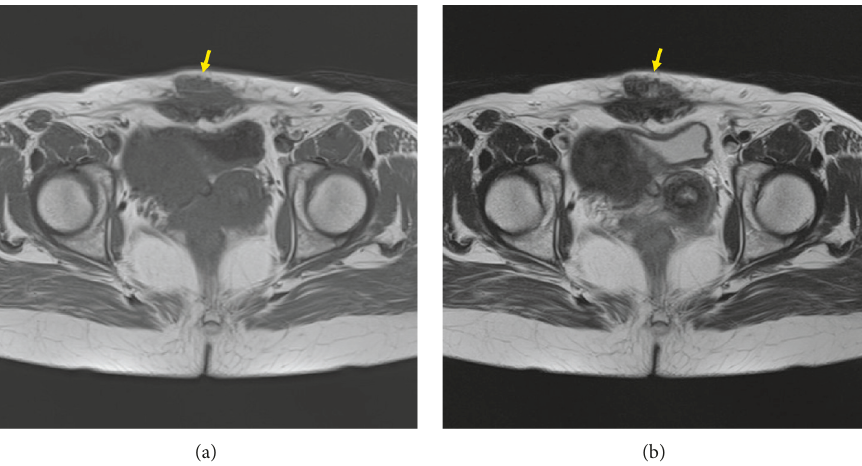
Figure 2: Preoperative MR images. (a) T1-weighted image. (b) T2-weighted image. A hypointense mass is observed within the rectus abdominis, as indicated by the yellow arrow. MR, magnetic